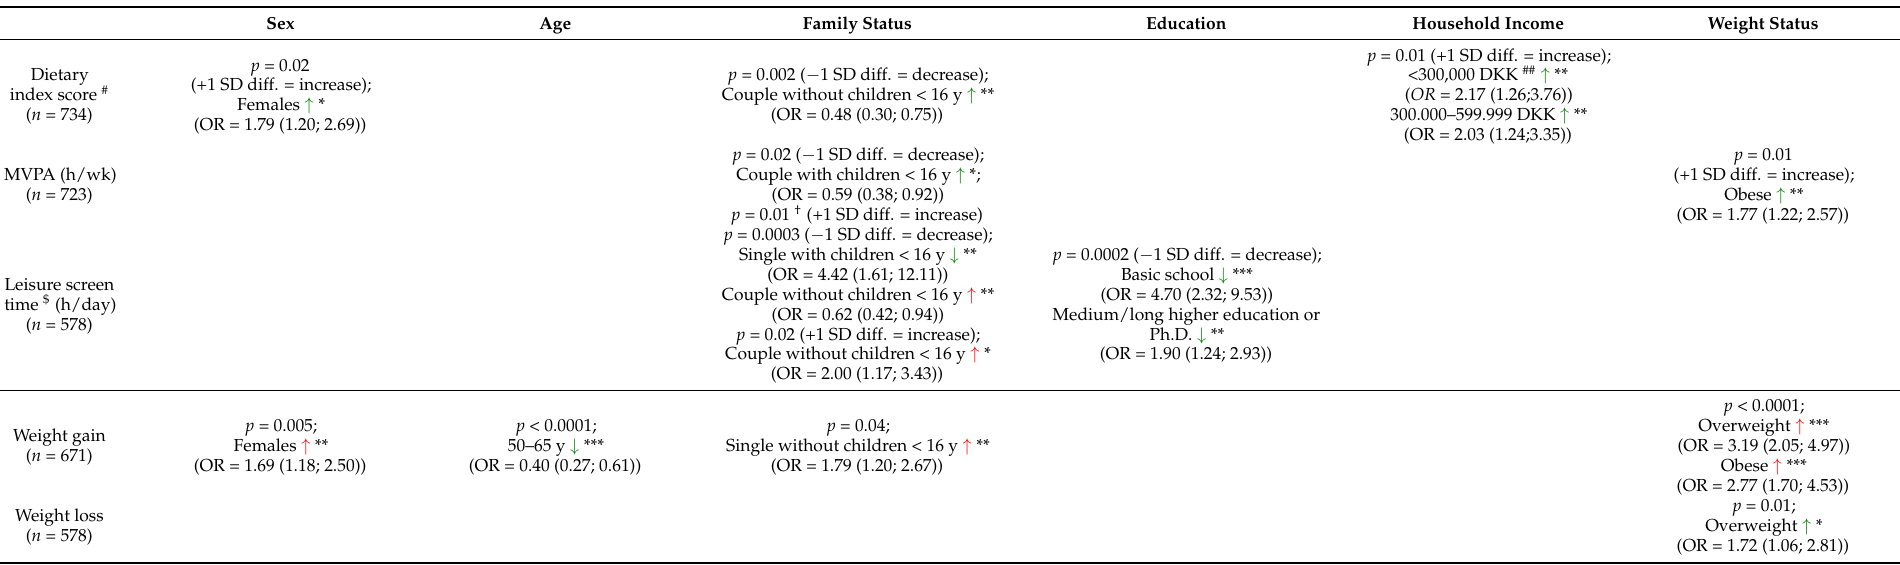
Table 4. Sociodemographic characteristics and weight status in Danish adults with a large change in the overall diet quality, MVPA, and leisure screen time after the lockdown using statistical modeling. Furthermore, sociodemographic characteristics of Danish adults with change in body weight during the lockdown